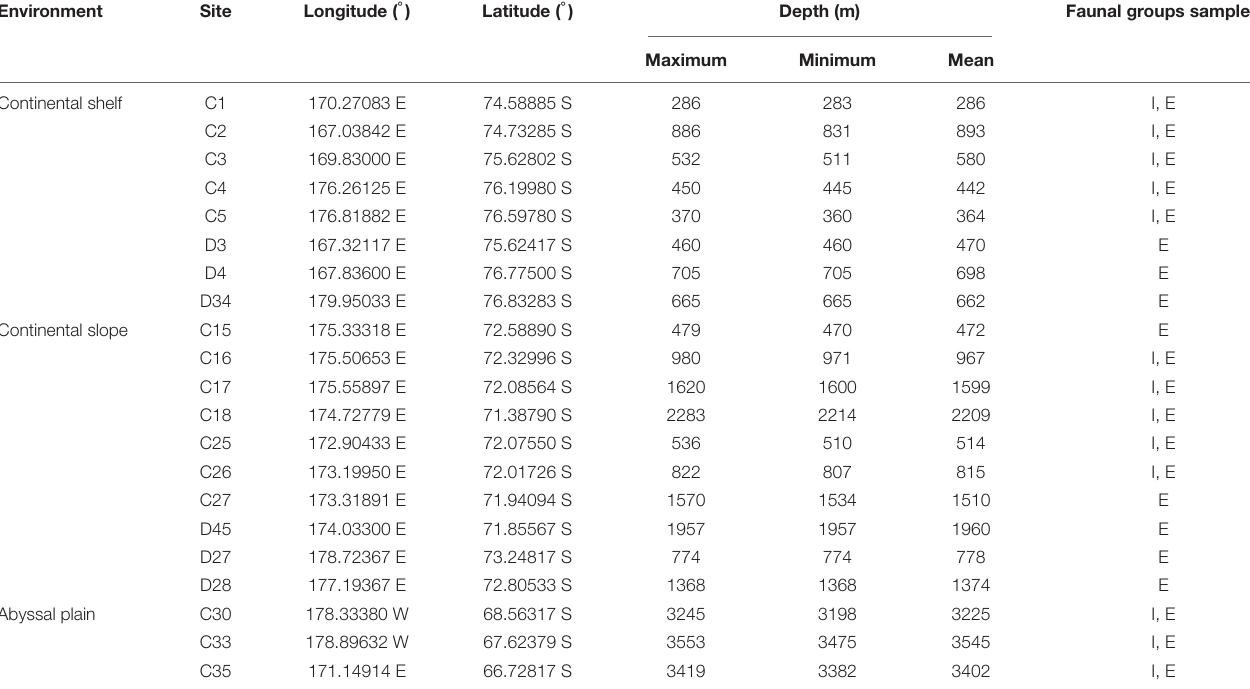
TABLE 1 | Details of benthic sampling